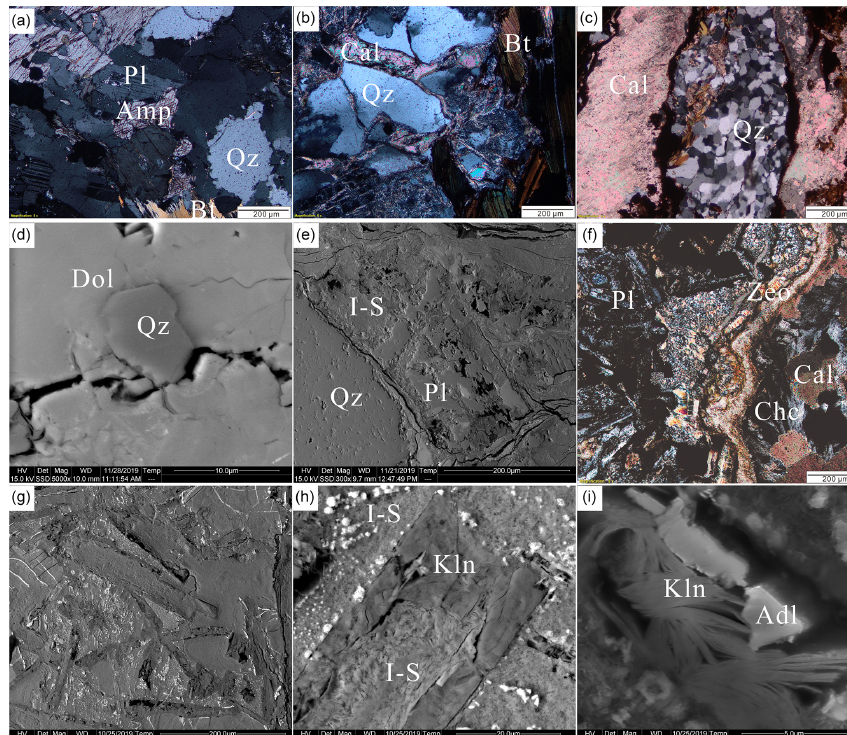
Figure 2. Petrographic characteristic of the basement and the overlying volcanic rock in the GA1 drill core: (a) fresh gabbroic diorite (PM, z = 55 . 5m); (b) gabbroic diorite (PM, z = 20 . 6m) and fractured quartz grain; (c) gabbroic diorite (PM, z = 23 . 5m) and recrystallized quartz coupled with a calcite filled in fracture; (d) gabbroic diorite (BSE, z = 21 . 5m) and dolomite accompanied by quartz; (e) gabbroic diorite (BSE, z = 20 . 6m) and partly weathered plagioclase. (f) basaltic andesite (PM, z = 17 . 8m) and fresh plagioclase grains with the amygdaloid consisting of calcite and zeolite and chalcedony; (g) basaltic andesite (BSE, z = 13 . 9m) secondary clay minerals with intact primary grain shapes; (h) basaltic andesite (BSE, z = 13 . 9m) and I–S surrounded by kaolinite within one residual plagioclase grain shape; (i) basaltic andesite (SEM, z = 13 . 9m) with kaolinite and adularia filled in the void. The abbreviations used in the figure and caption are as follows: